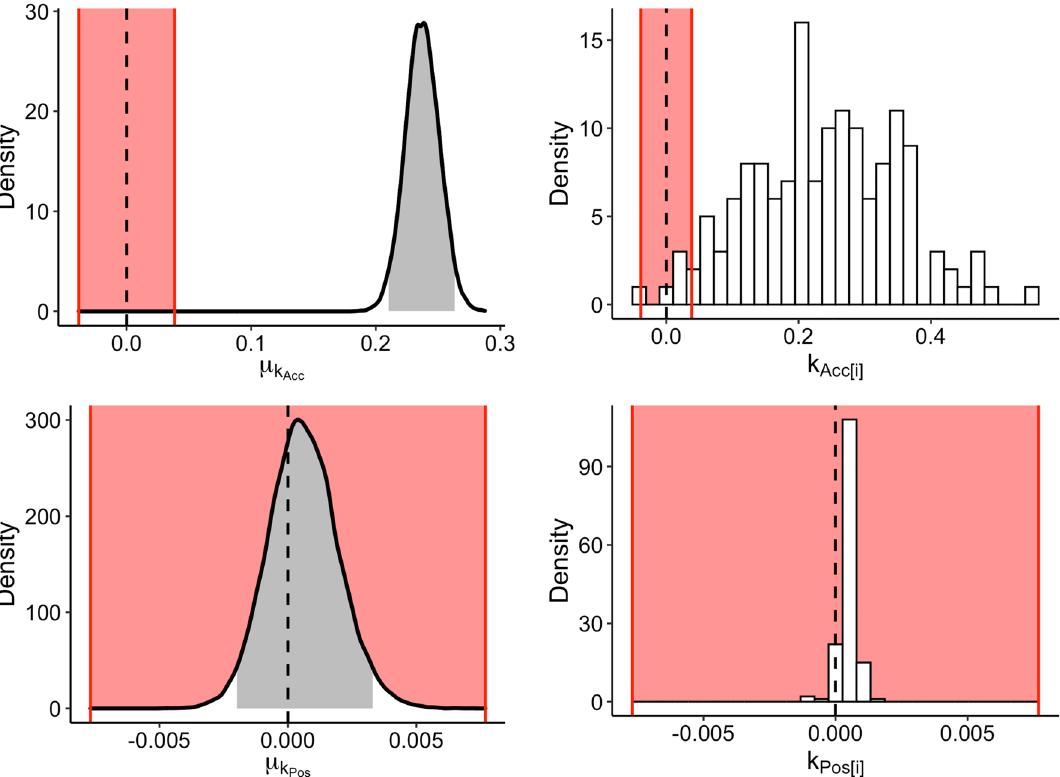
Figure 4. Left column: Posterior distribution of the hyperparameters µ k Acc and µ k Pos obtained from fitting the Full Model . The grey shaded areas denote the 95% highest density intervals. Right column: Histograms of individual parameter point estimates of k Acc and k Pos for each participant. In all plots, the red shaded areas indicate the region of practical equivalence, within which parameter values can be inferred to be meaningfully equivalent to